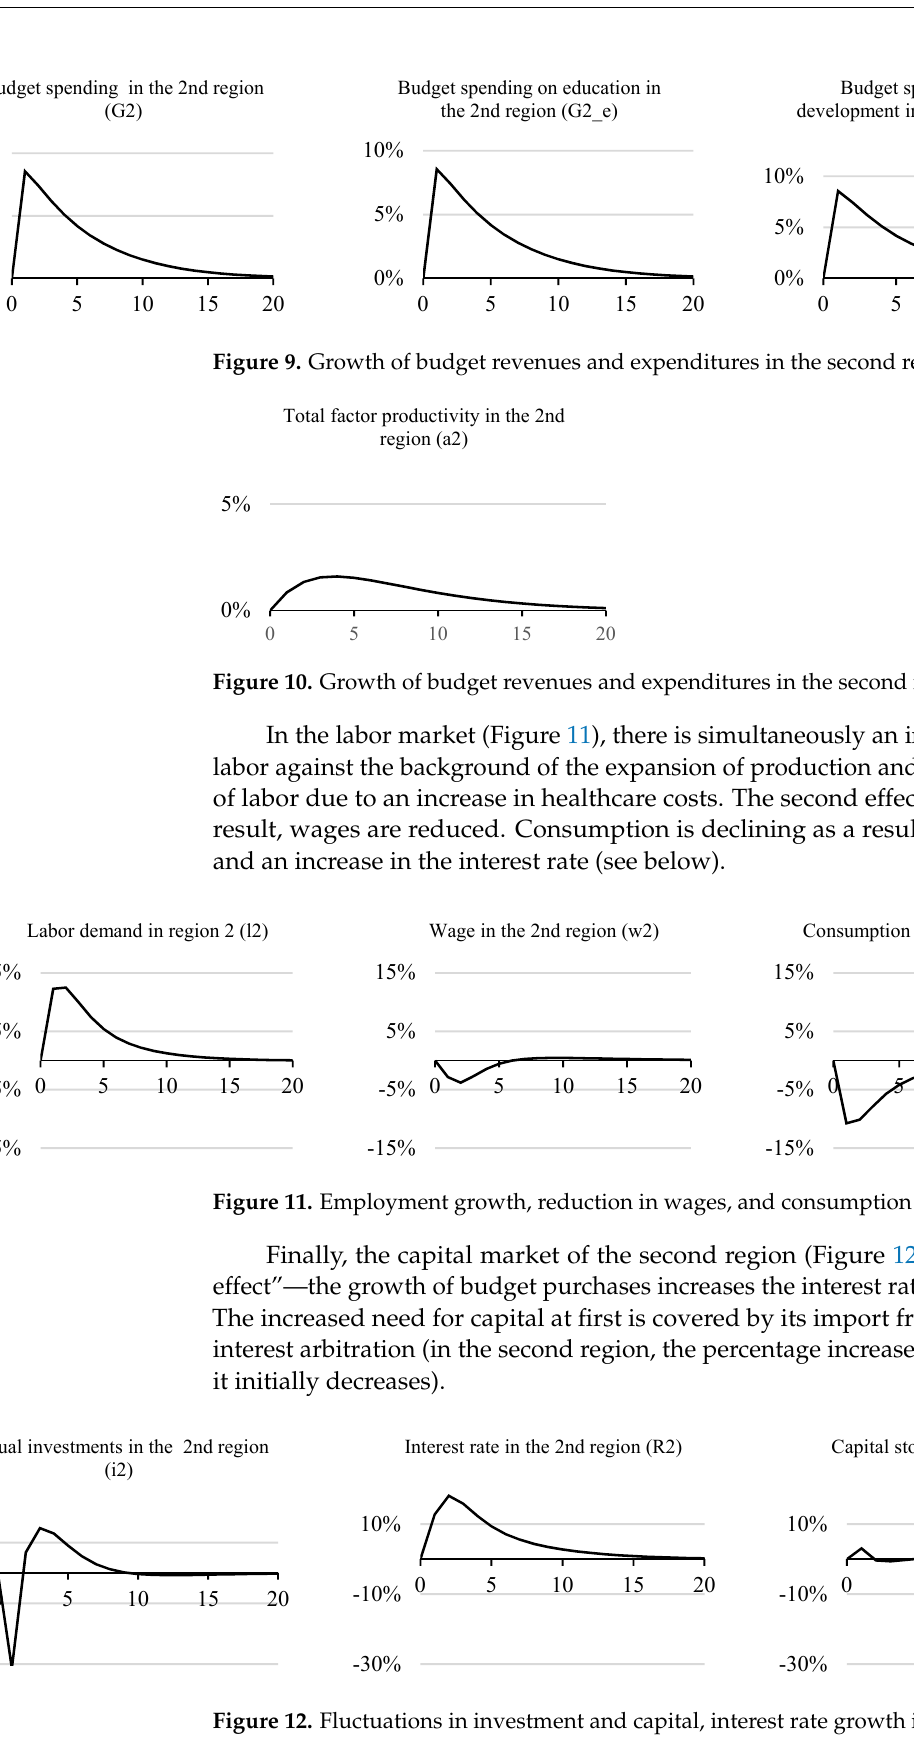
Figure 8. Output growth in the second region.